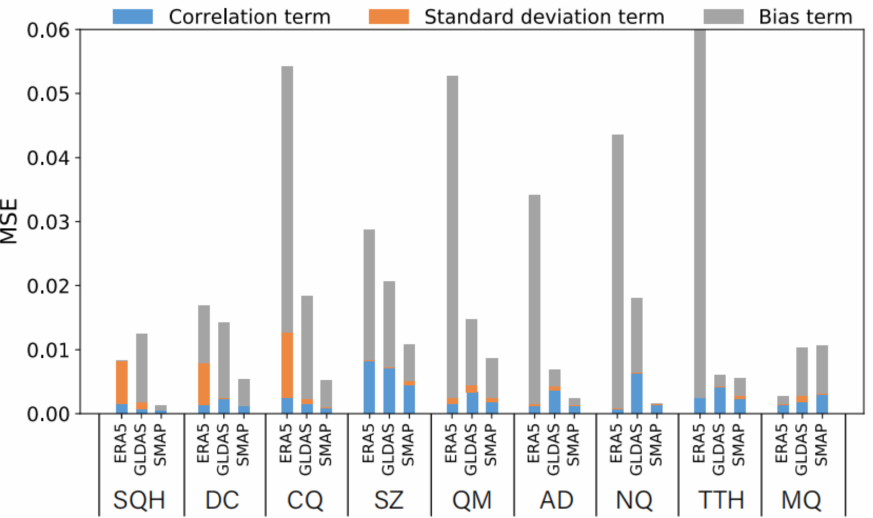
Figure 4. Decomposition of the three terms of the mean square error (MSE) for the three soil moisture products at nine observation stations.